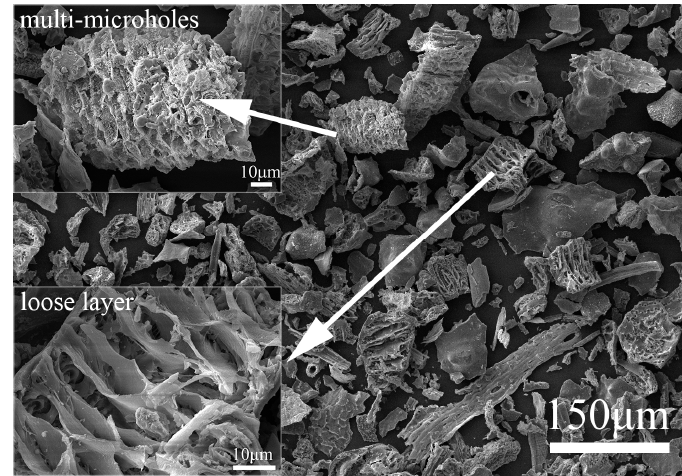
Figure 2. SEM images of RHA calcined at 600 °C for 2 h.